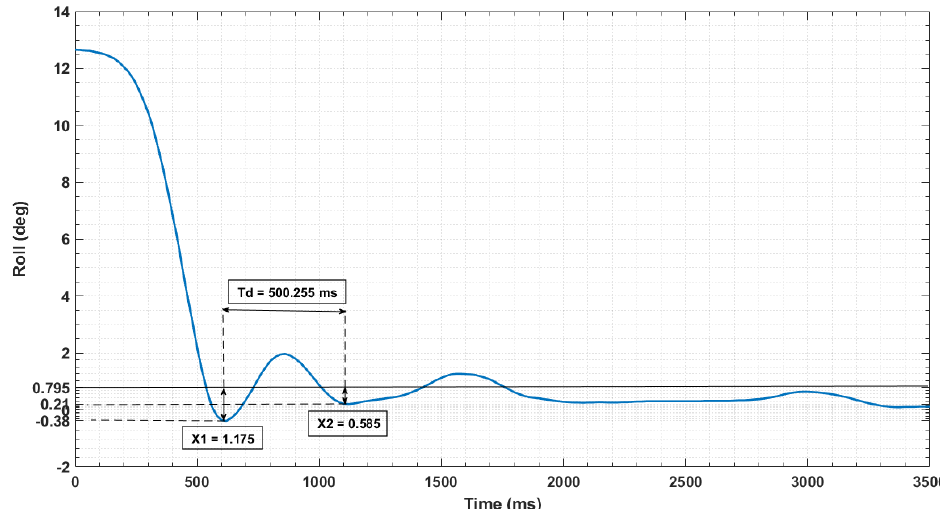
Figure 5. Roll stability test